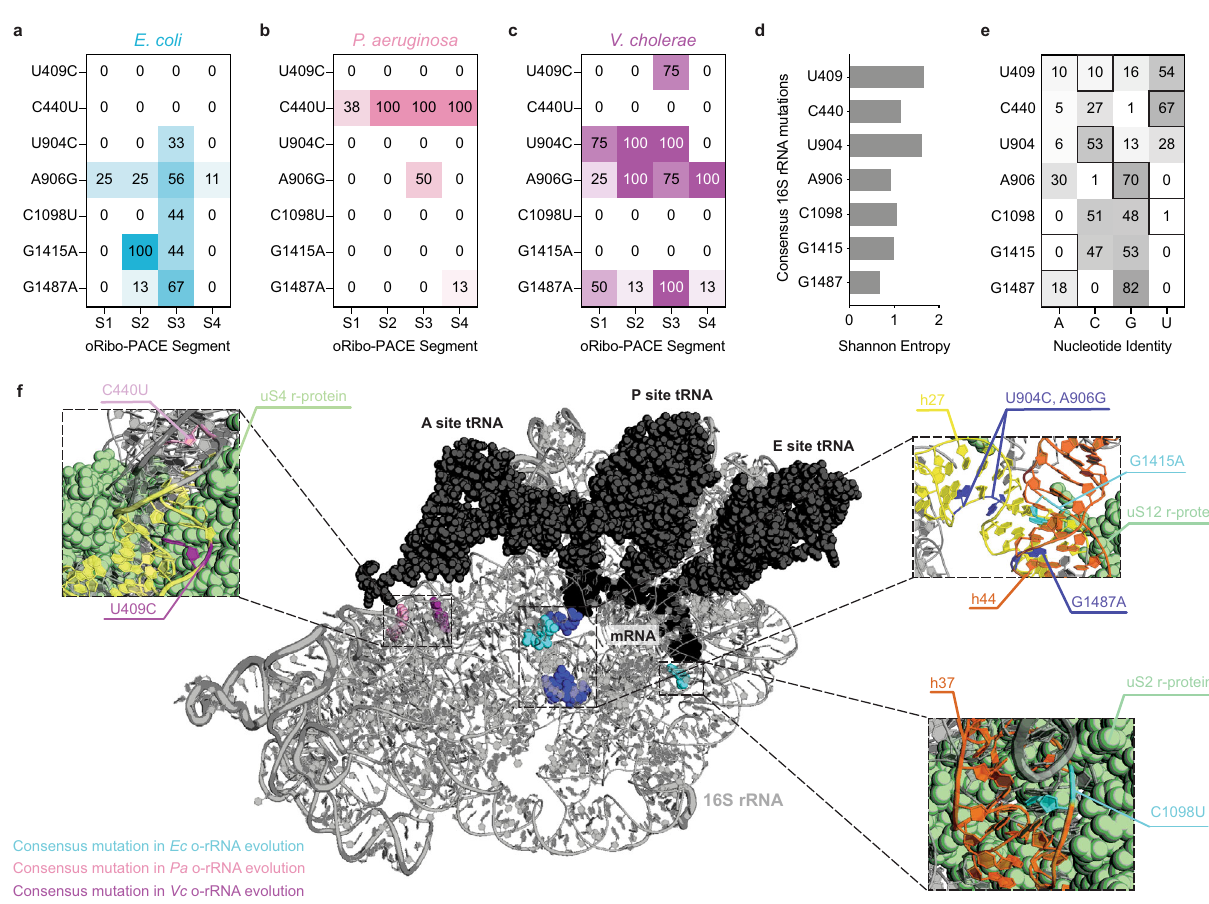
Fig. 4 Shared consensus mutations in 16S rRNAs following continuous evolution. An overview of consensus rRNA mutations observed in oRibo-PACE for each starting rRNA species and selection. Values represent % of sequenced clones from each segment ( a – c ). d Shannon entropy for positions where consensus mutations were discovered in oRibo-PACE. e Phylogenetic divergence at positions mutated during oRibo-PACE (outlined squares) show no correlation between a discovered o-rRNA mutation and nucleotide conservation at that position. Shannon entropy values and nucleotide abundance were both obtained from RiboVision 60 . f Consensus rRNA mutations discovered in PACE and their locations on the ribosome. Most ribosomal proteins have been omitted for clarity. A close-up view of h37 in the 16S rRNA and the C1098U mutation in relation to ribosomal protein uS2. Close-up locations of U409C ( V. cholerae only) and C440U ( P. aeruginosa only) mutations in relation to ribosomal protein uS4. And a close-up view of mutations discovered by ≥ 2 rRNA evolution campaigns on h27 and h44 in relation to uS12. For all parts, images were generated from a 2.8-Å Thermus thermophilus 70S ribosome structure (PDB 4v51 61 ). All positions are numbered using E. coli 16S rRNA nomenclature. Source data are available in the Source Data